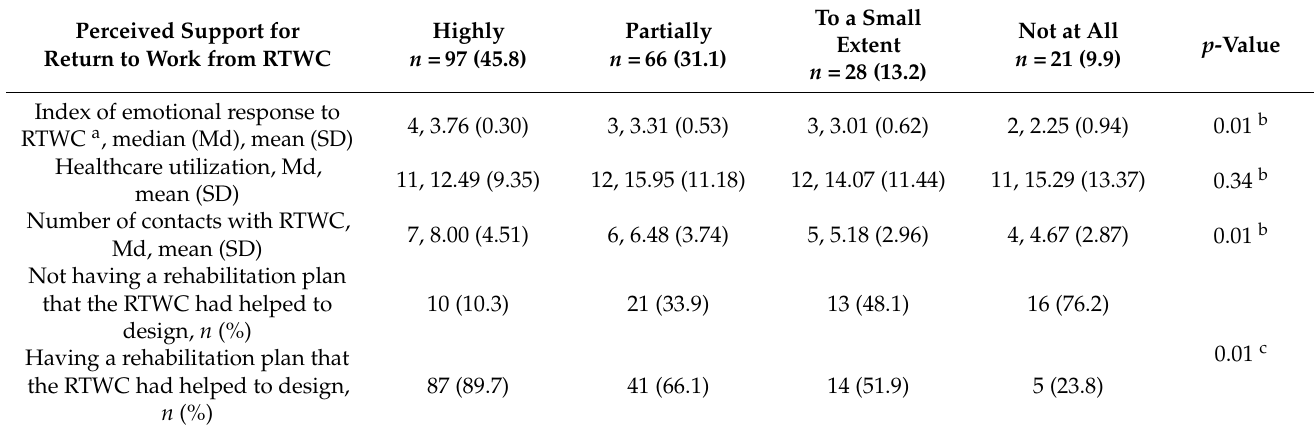
Table 2. Emotional support for return-to-work, number of contacts with RTWC, rehabilitation plan that the RTWC had helped to design, distributed on support for return-to-work from